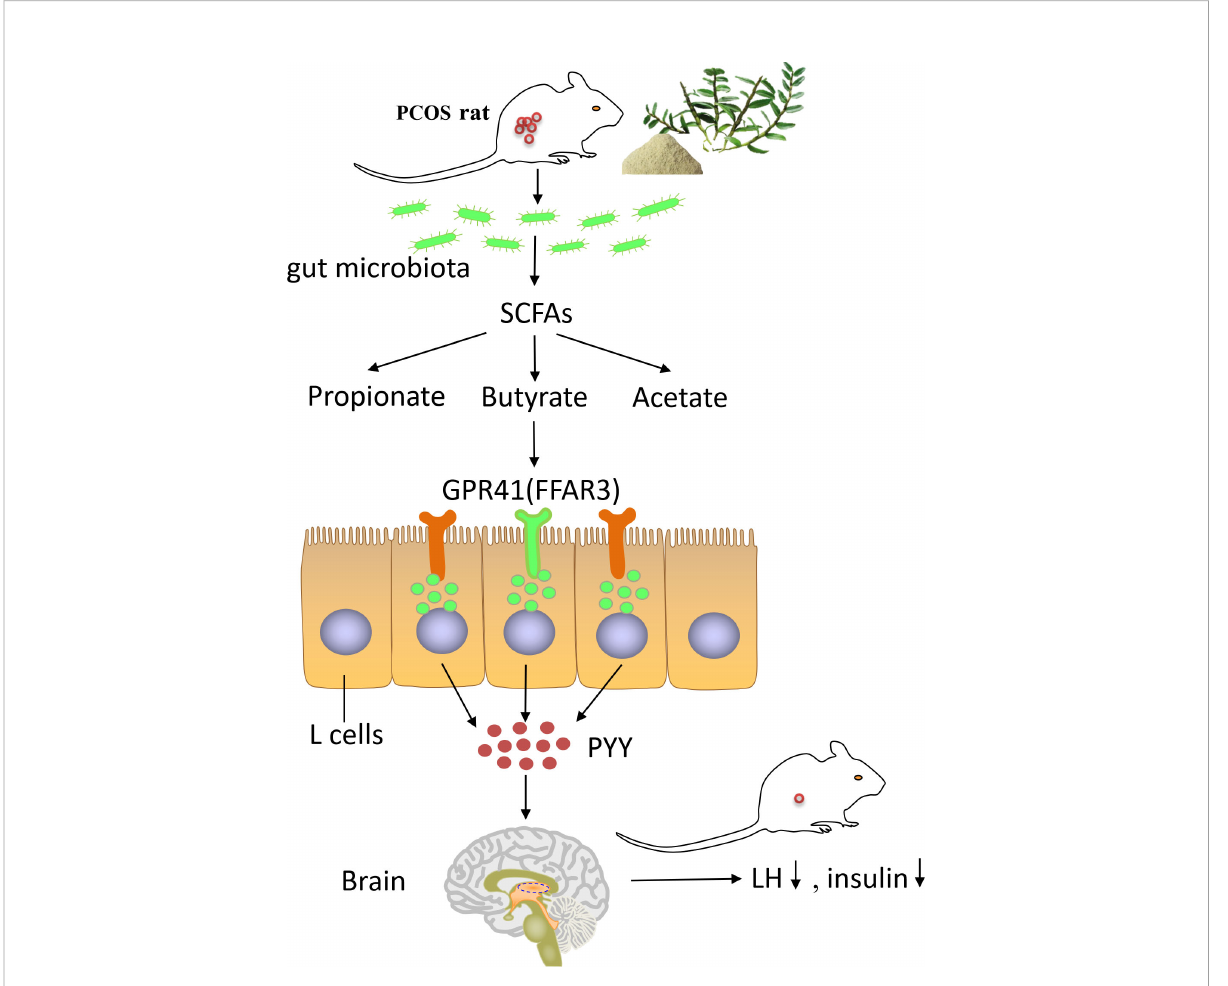
FIGURE 10 The summary of how DOP alleviates PCOS through gut – brain – ovary regulation. Dendrobium of fi cinale polysaccharide can promote the remodeling of the gut microbiota and the production of butyrate bacterium in PCOS rats. High levels of butyrate through G protein-coupled receptor 41 to stimulate the secretion of PYY by entero-endocrine L-cells. PYY regulates the levels of steroid hormones through the gut – brain axis and ameliorates the polycystic ovary phenotype in PCOS